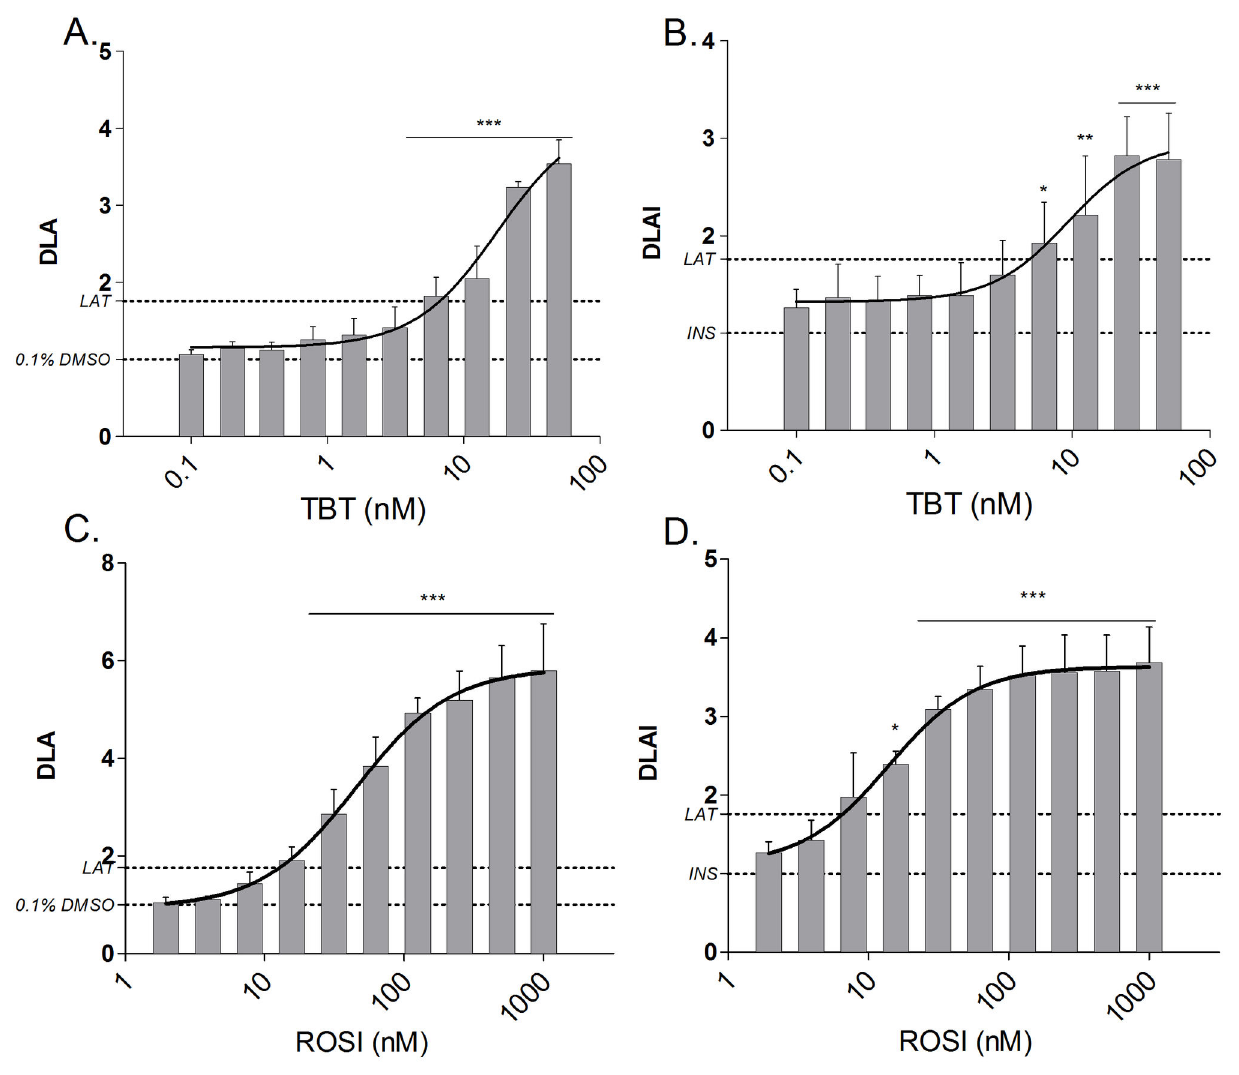
Figure 3. Effect of reference compounds on adipocyte differentiation in 3T3-L1 cells after 10 days of exposure. Fluorimetric quantification of lipid accumulation was performed using Nile Red staining. The degree of lipid accumulation induced by TBT in absence (A.) or presence (B.) of insulin and by ROSI in absence (C.) or presence (D.) of insulin are represented as mean (±SD) of three independent experiments Data represent mean (±SD) of the degree of lipid accumulation (with insulin) (DLA(I)) of three independent experiments (each with 4 replicates) (n=3). Significant differences with solvent control (0.1% DMSO or INS) are indicated with asterisks (One Way ANOVA Dunnet’s post hoc test; *p≤0.05; **p≤0.01; ***p≤0.001). Additionally, a sigmoidal dose −response curve was fitted (GraphPad Prism). LAT: Lipid Accumulation Threshold